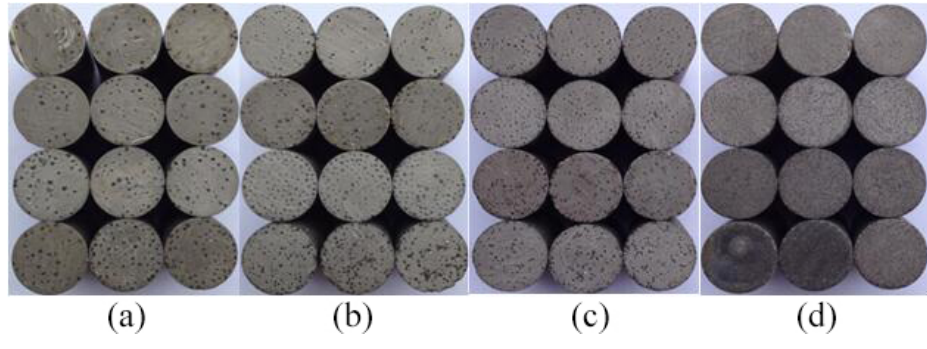
Figure 3. Experimental impregnated teeth.